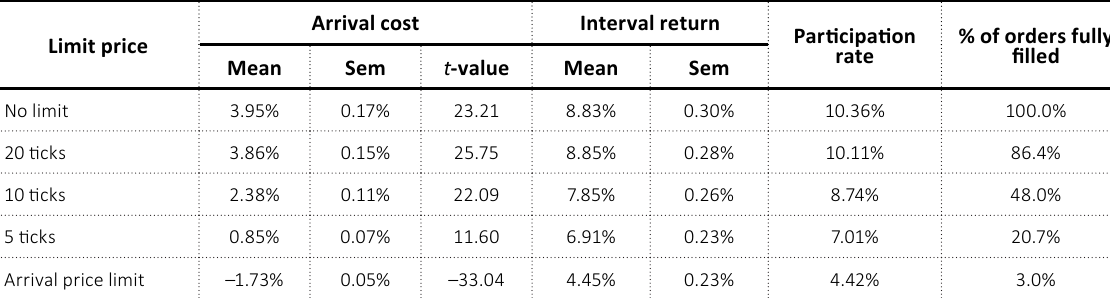
Figure 7. Arrival costs and probability of order to be fully Table 3. Execution cost and trading stats for various metaorder limits